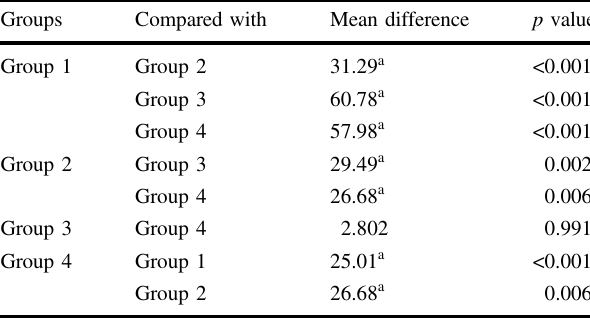
Table 1 Multiple comparisons for centre of defect using tukey HSD Groups